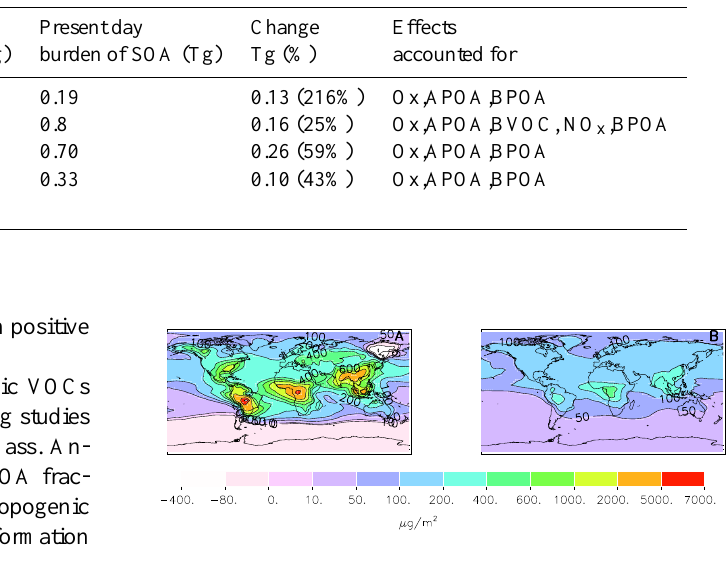
the pre-industrial period, while (B) shows the mass formed directly from anthropogenic SOA